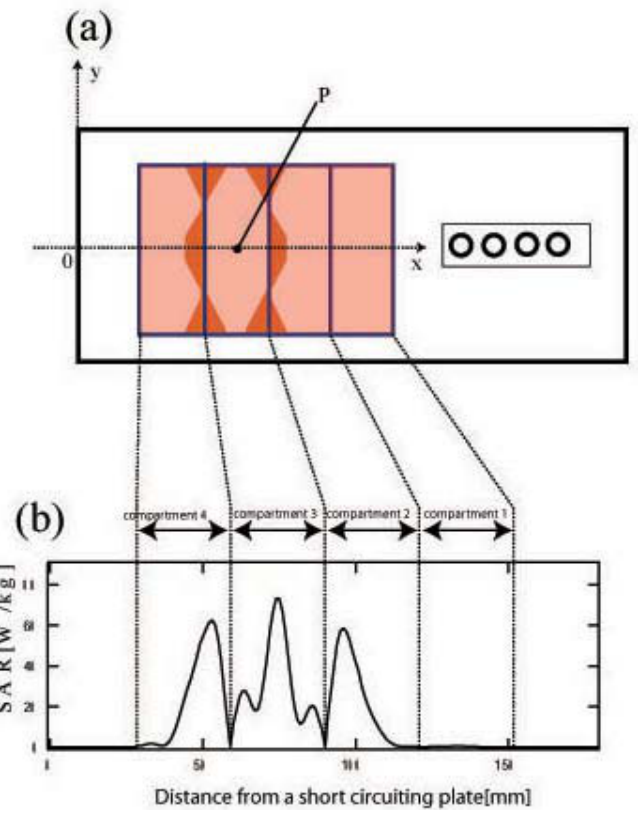
FIGURE 2 . SARs distribution in the exposure setup, obtained from calculations using the FDTD